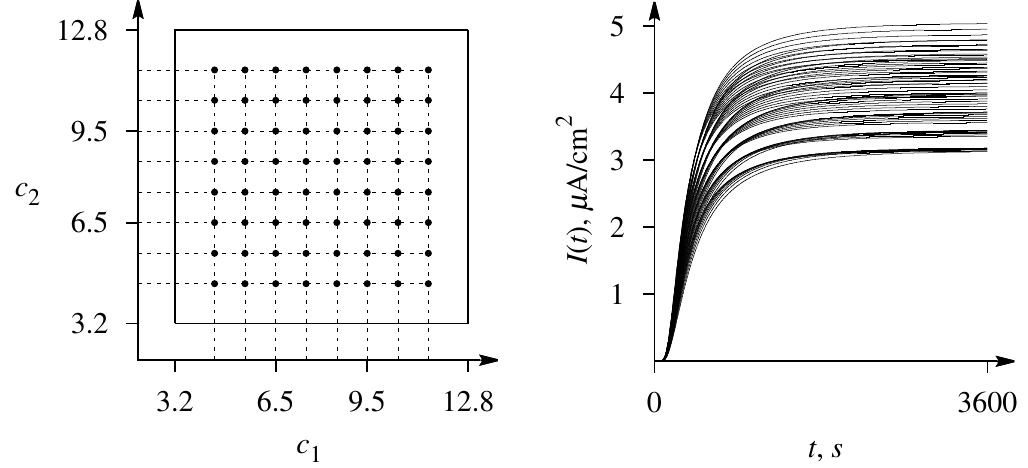
= 0 . 5 µ M / s , V = 5 µ M / s and β = 0 . 4 . 1 2